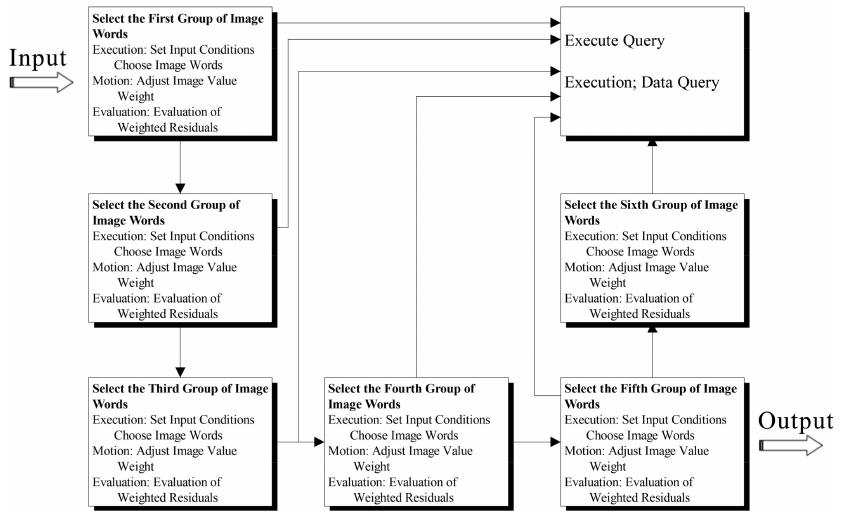
Figure 10. Simply consider multiple input word values as main set input